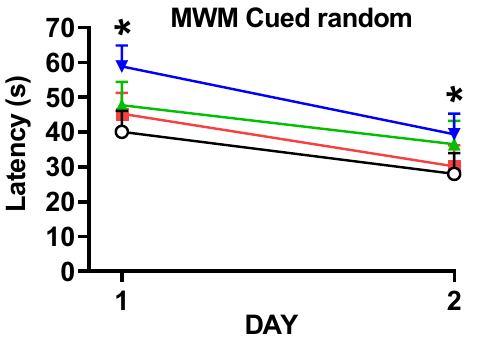
Figure 10. Cued-random phase Morris water maze performance in proton irradiated and control rats. * p < 0.05, 17 Gy compared with controls. N = 10/control, 11 Gy, and 17 Gy and n = 8 for the 14 Gy.